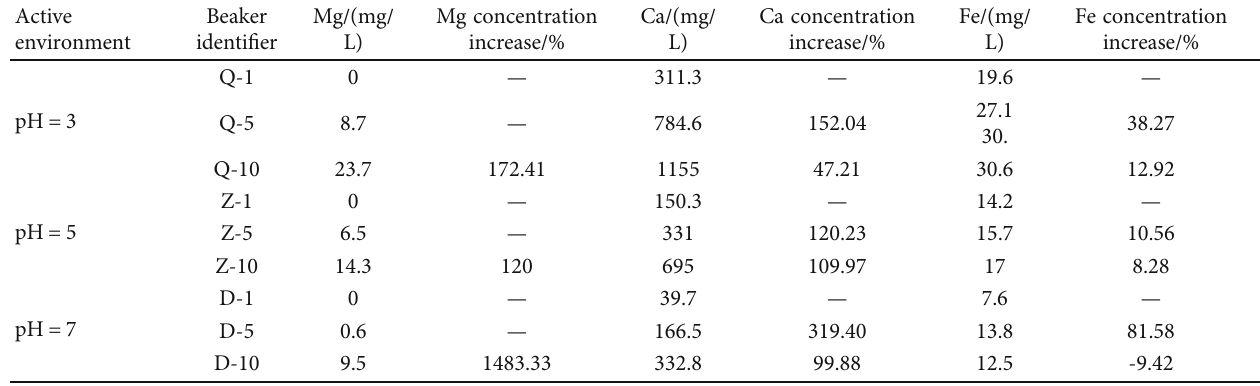
Table 7: Results of the mass concentration of each main element after di ff erent dry-wet cycles.